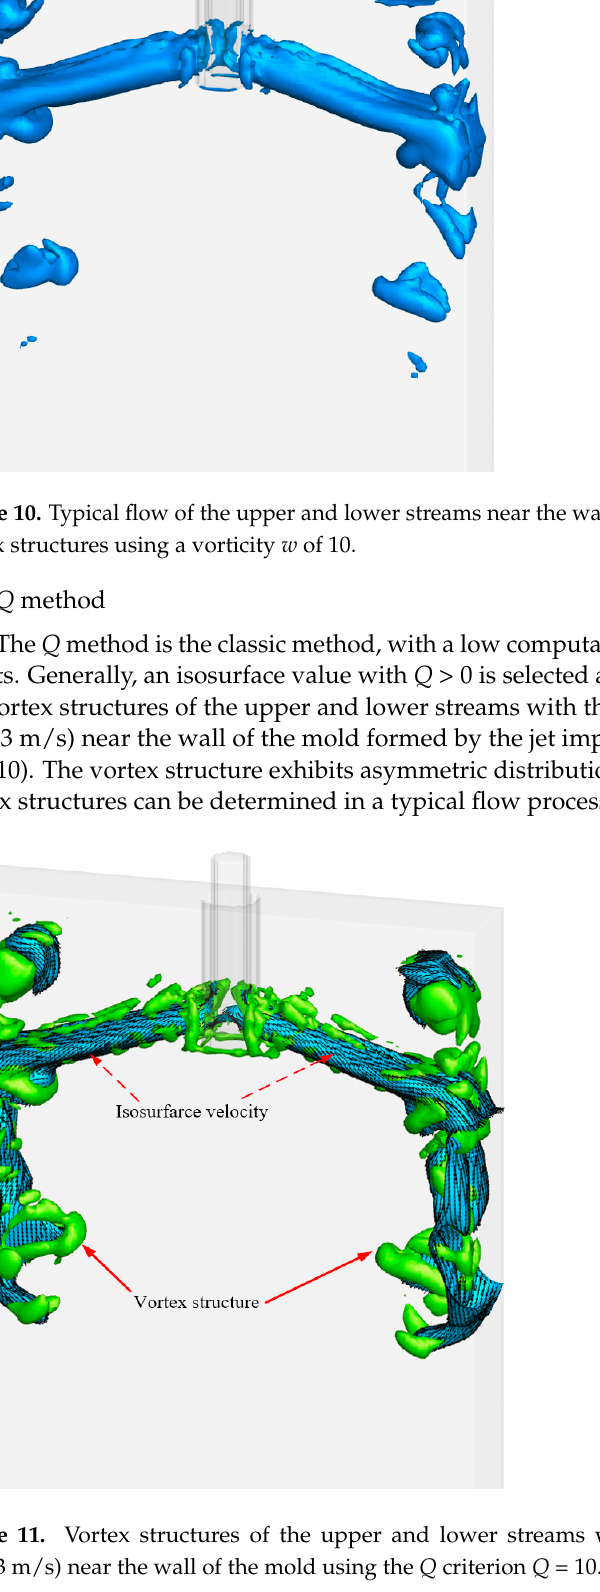
Figure 11. Vortex structures of the upper and lower streams with the jet (velocity isosurface v = 0.3 m/s) near the wall of the mold using the Q criterion Q = 10. v = 0.3 m/s) near the wall of the mold using the Q criterion Q =